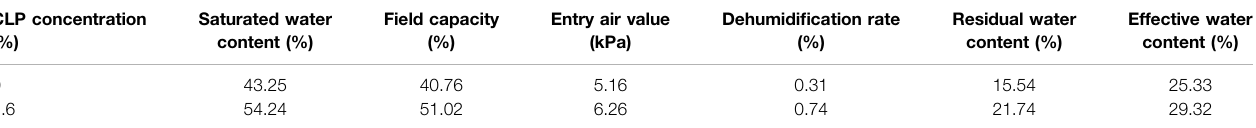
TABLE 2 | Soil-water characteristic parameters of treated and untreated loess.